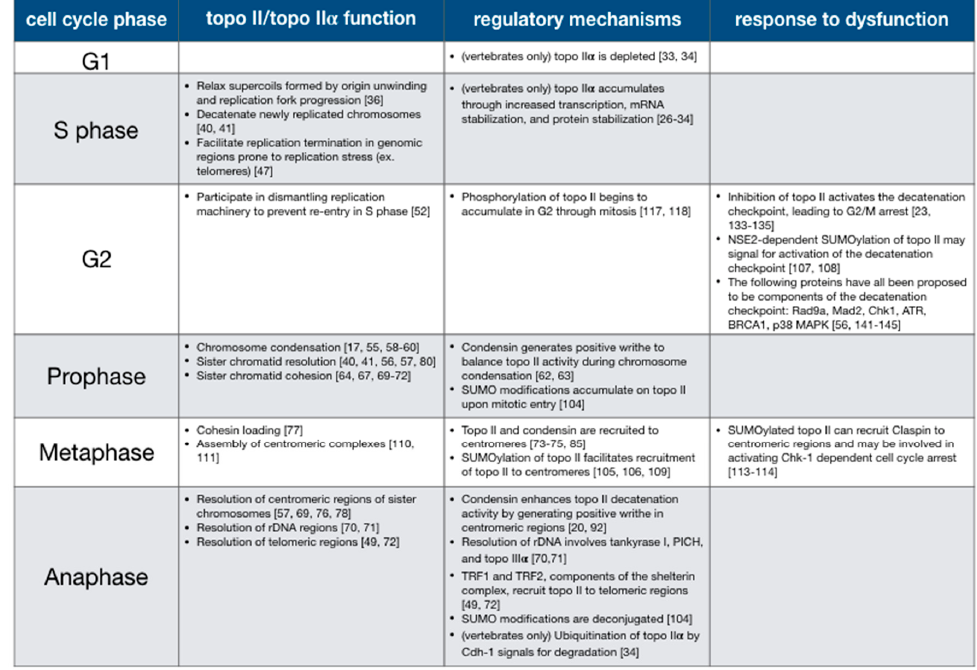
Figure 4. of topo II functions and regulatory mechanisms throughout the cell cycle. Figure 4. Summary of topo II functions and regulatory mechanisms throughout the cell